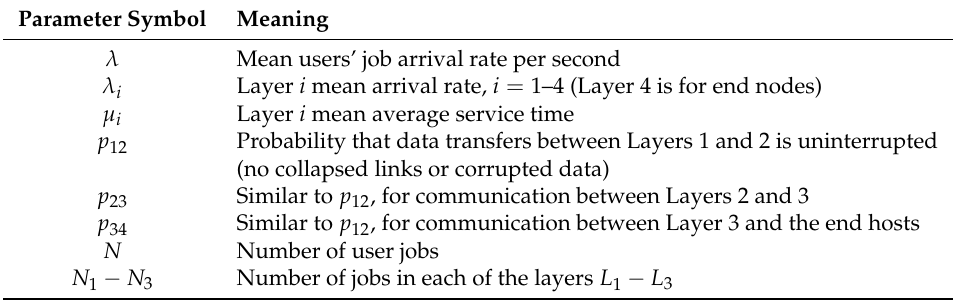
Table 1. List of parameters required by the Probabilistic Model